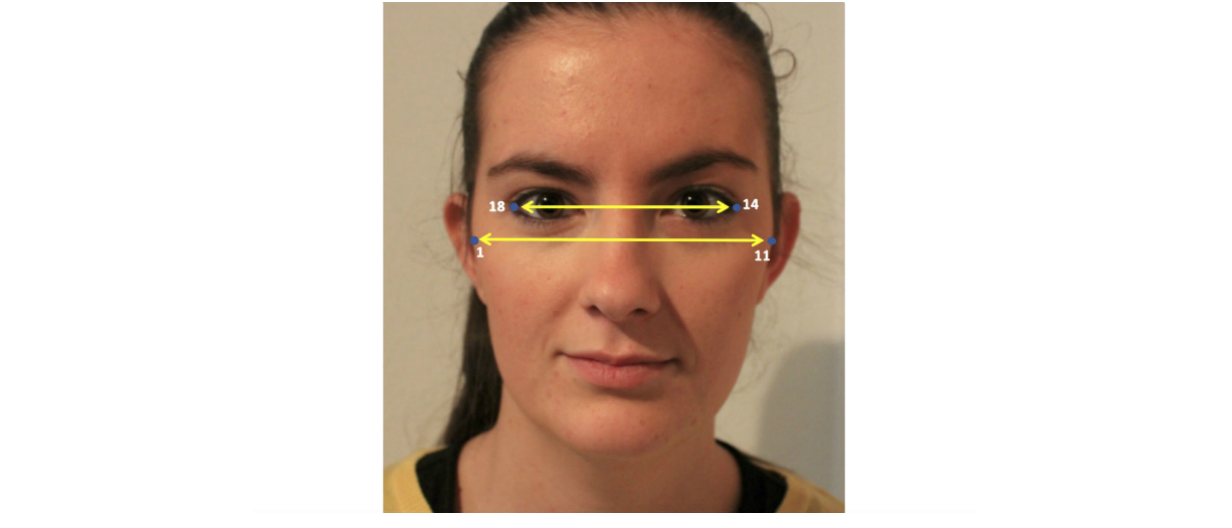
Figure 4. Measurements used for the face-width ratio.